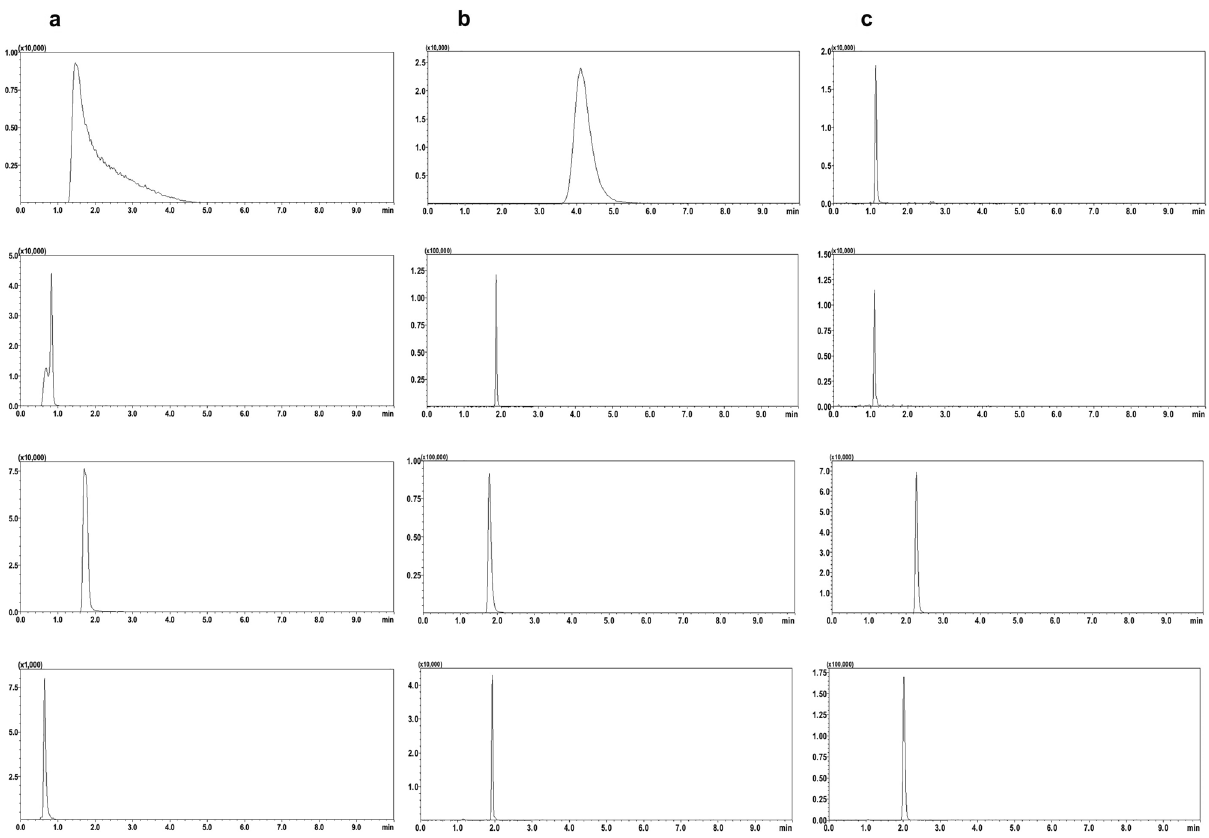
Figure 1. LC–MS/MS chromatograms of the standard solution, matrix-matched solution, standard solution with a mobile phase containing 0.1% formic acid, and matrix-matched solution with a mobile phase containing